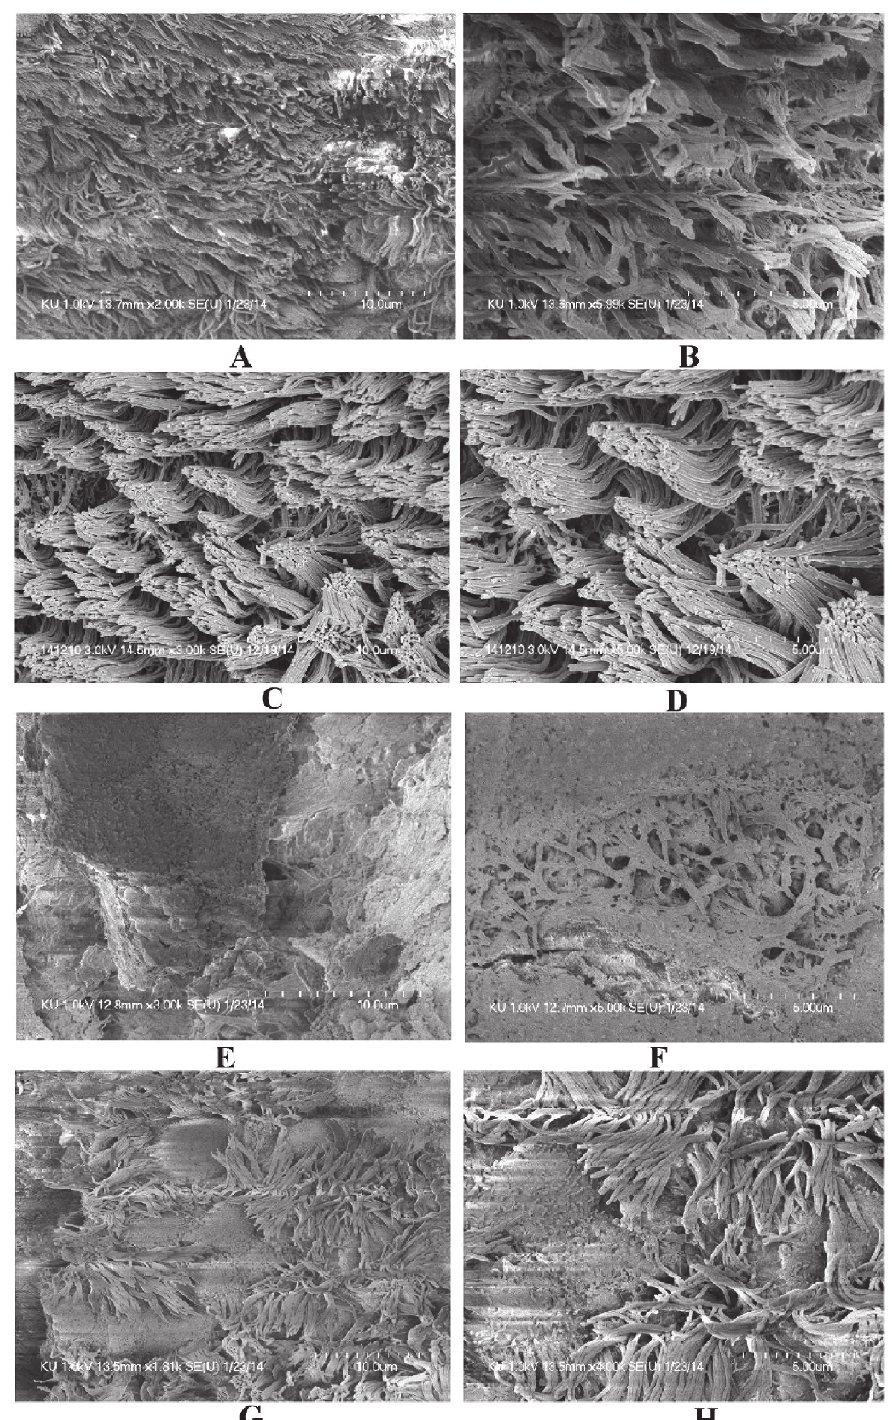
Fig 6. The effect of eugenol on colonization of S. aureus (ATCC 29213) in middle ear of rat in vivo . (A&B) Representative SEM images of no procedure control rat middle ear. (C & D) Representative SEM images of middle ear of rat inoculated with DMSO. (E & F) Representative SEM images of middle ear of rat inoculated with bacteria only. (G & H) Representative SEM images of middle ear of rat inoculated with bacteria and eugenol. Images scale bars correspond to 5 and 10 μ